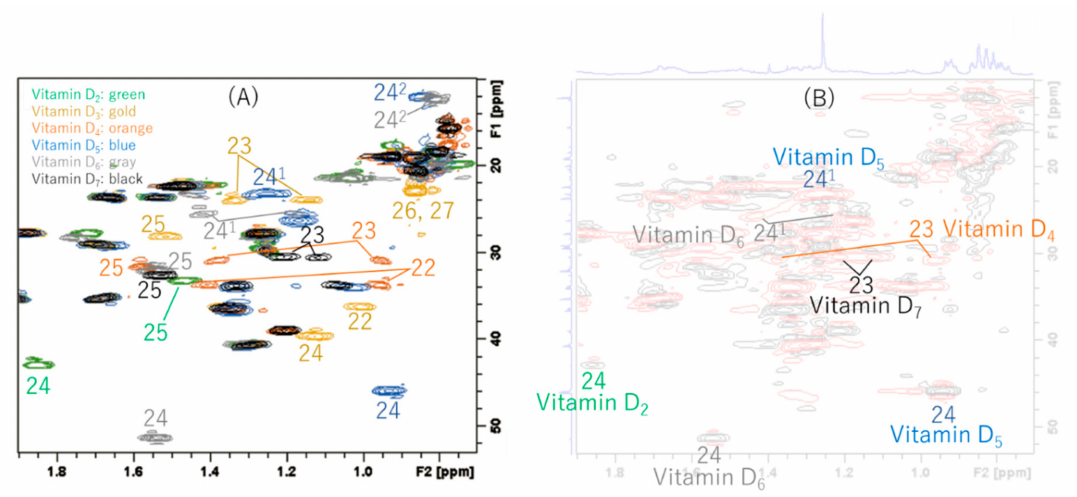
Figure 7. Analyses of HSQC NMR spectra. ( A ) Superimposed HSQC NMR charts of vitamins D 2 , D 3 , D 4 , D 5 , D 6 , and D 7 were measured separately. They are color coded in green, gold, orange, blue, gray, and black, respectively. The following characteristic peaks were observed respectively. Vitamin D 2 has CH-24, 25, vitamin D 3 has CH-22, 23, 24, 25, 26, 27, vitamin D 4 has CH-22, 23, 25, vitamin D 5 has CH-24, 24 1 , 24 2 , vitamin D 6 has CH-24, 24 1 , 24 2 , 25, and vitamin D 7 has CH-23, 25. Although not in this range, both vitamins D 2 and D 6 also have CH-22, 23 as characteristic peaks. ( B ) HSQC NMR of the vitamin D mixture synthesized in this study. Methine (CH) / methyl (CH 3 ) resonances have a positive intensity and are plotted in black; methylene (CH 2 ) resonances have a negative intensity and are plotted in